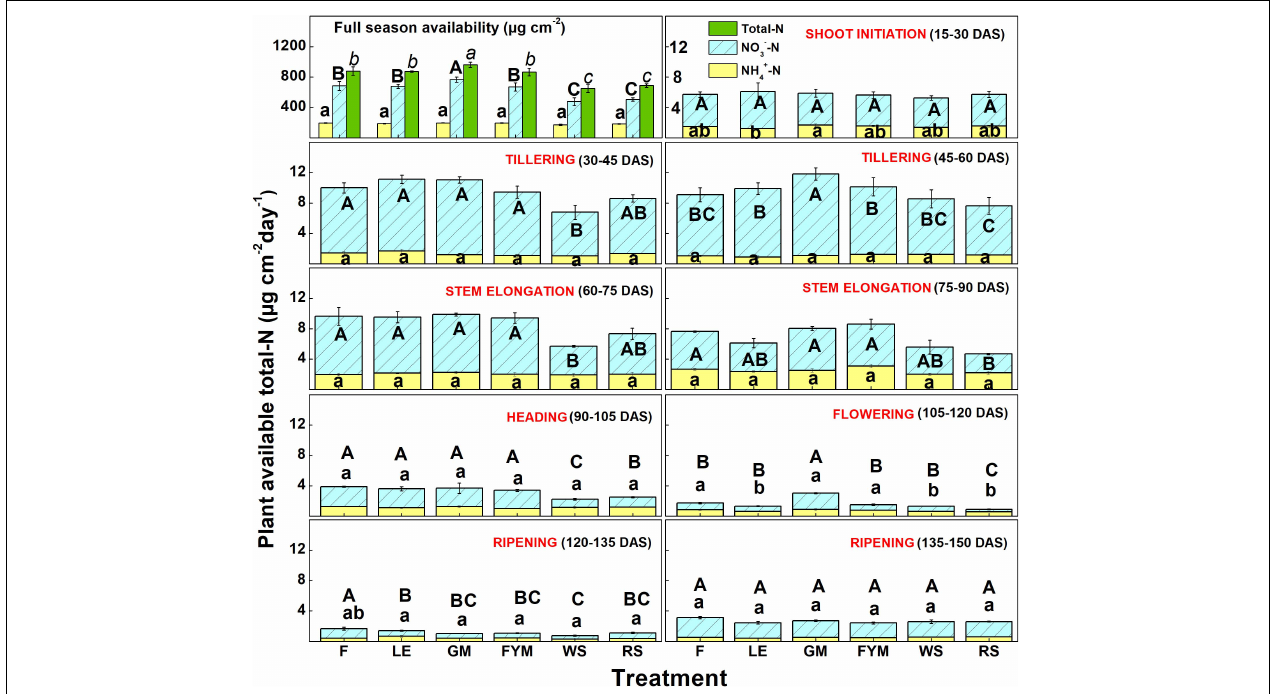
FIGURE 2 | Full season and daily NO 3 − -N, NH 4 + -N, and total N availability scenarios with days after sowing (DAS) for wheat ( Triticum aestivum ) crop (stage-wise averaged for 2014–15 and 2015–16). For respective parameter, treatments with same digits are not significantly different at p ≤ 0.05, using Tukey’s HSD. IER, Ion exchange resin strips. Small letters represent differences for NO 3 − -N, small italic letters represent differences for NH 4 + -N, and capital letters represent differences for total plant-available N. Error bars denote ± 1SD. Management: F = 100% inorganic fertilizers, LE, Legume crop ( Vigna radiata ) in rotation and its biomass incorporation + 55% inorganic fertilizers, GM, Green manuring with Sesbania aculeata + 55% inorganic fertilizers, FYM, farmyard manure incorporation + 55% inorganic fertilizers, WS = 1/3rd wheat stubble retention and incorporation + 55% inorganic fertilizers, RS = 1/3rd rice stubble retention and incorporation + 55% inorganic